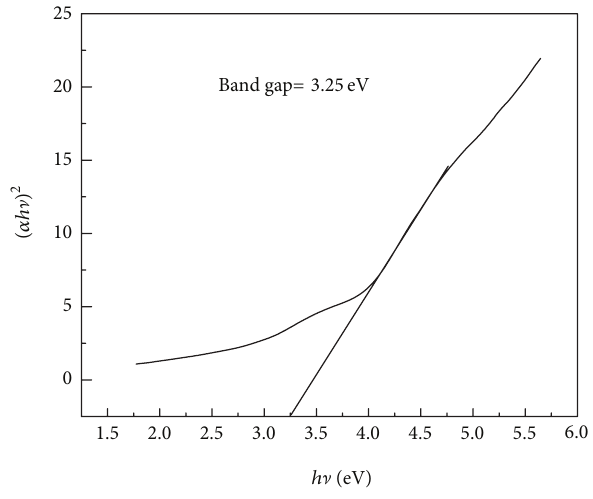
Figure6:Tauc’splotoftheopticalabsorptionspectrumofCaNb 2 O 6